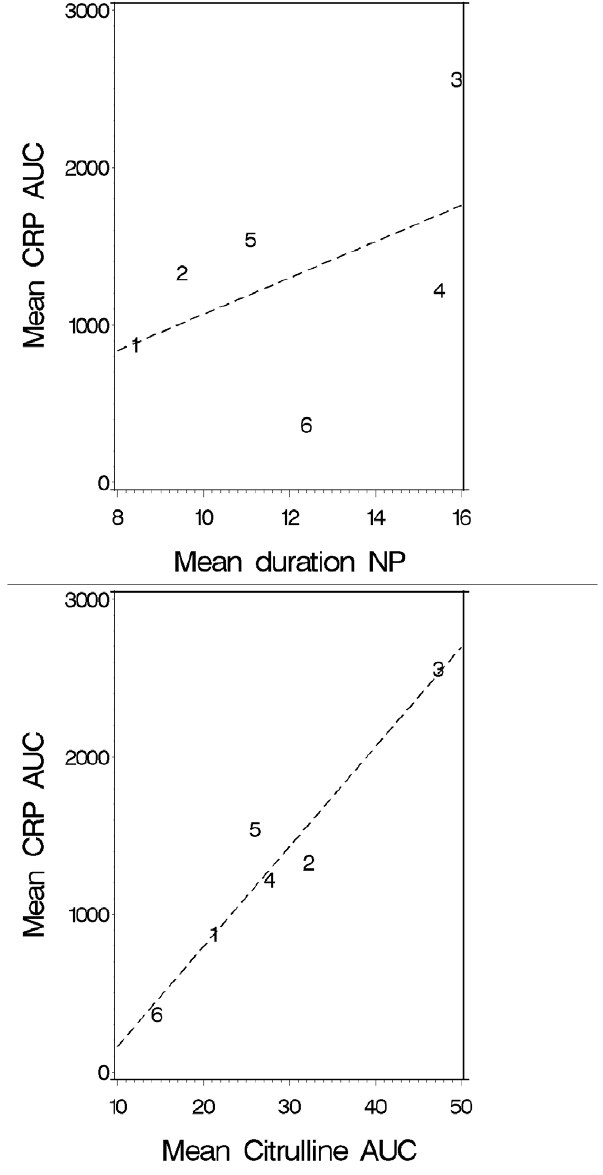
Figure 3. Pearson correlation between the mean degrees of neutropenia (NP in days) and inflammation (CRP AUC ) versus intestinal damage (Citrulline AUC ) and inflammation (CRP AUC ) over the different regimens. 1=HDM, 2=BEAM, 3=Ida-Cyclo-TBI, 4=Cyclo-ATG-TBI, 5=Cyclo-TBI, 6=Cyclo-Flu.